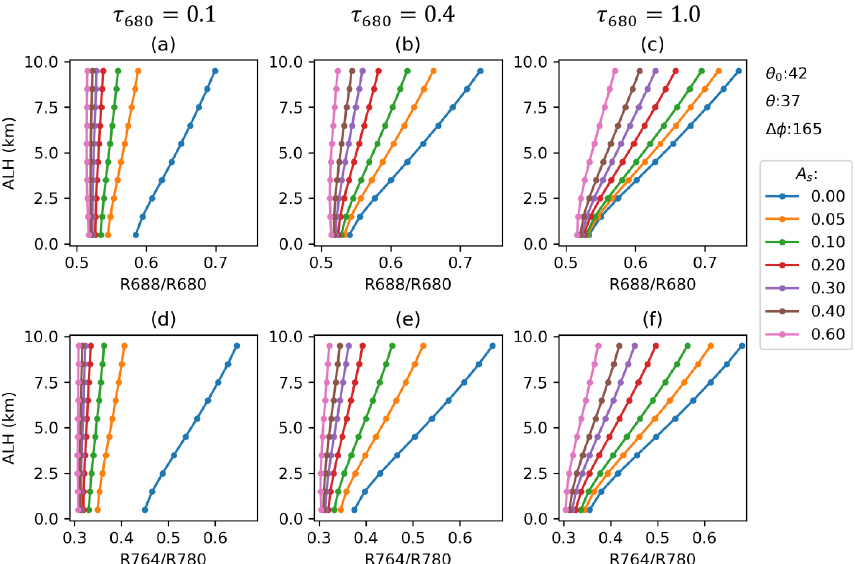
Figure 3. Sensitivity of DOAS ratios of TOA reflectance around the O 2 A and B bands to smoke ALH as simulated by UNL-VRTM for different AOD and surface reflectance ( A s ) values. Simulations were performed for a typical biomass burning aerosol model as observed by EPIC for the geometry of (cid:2) θ 0 ,θ, (cid:49)φ (cid:3) = [ 42, 37, 165 ◦ ], where θ 0 and θ are solar and viewing zenith angles, and (cid:49)φ the relative azimuth angle.